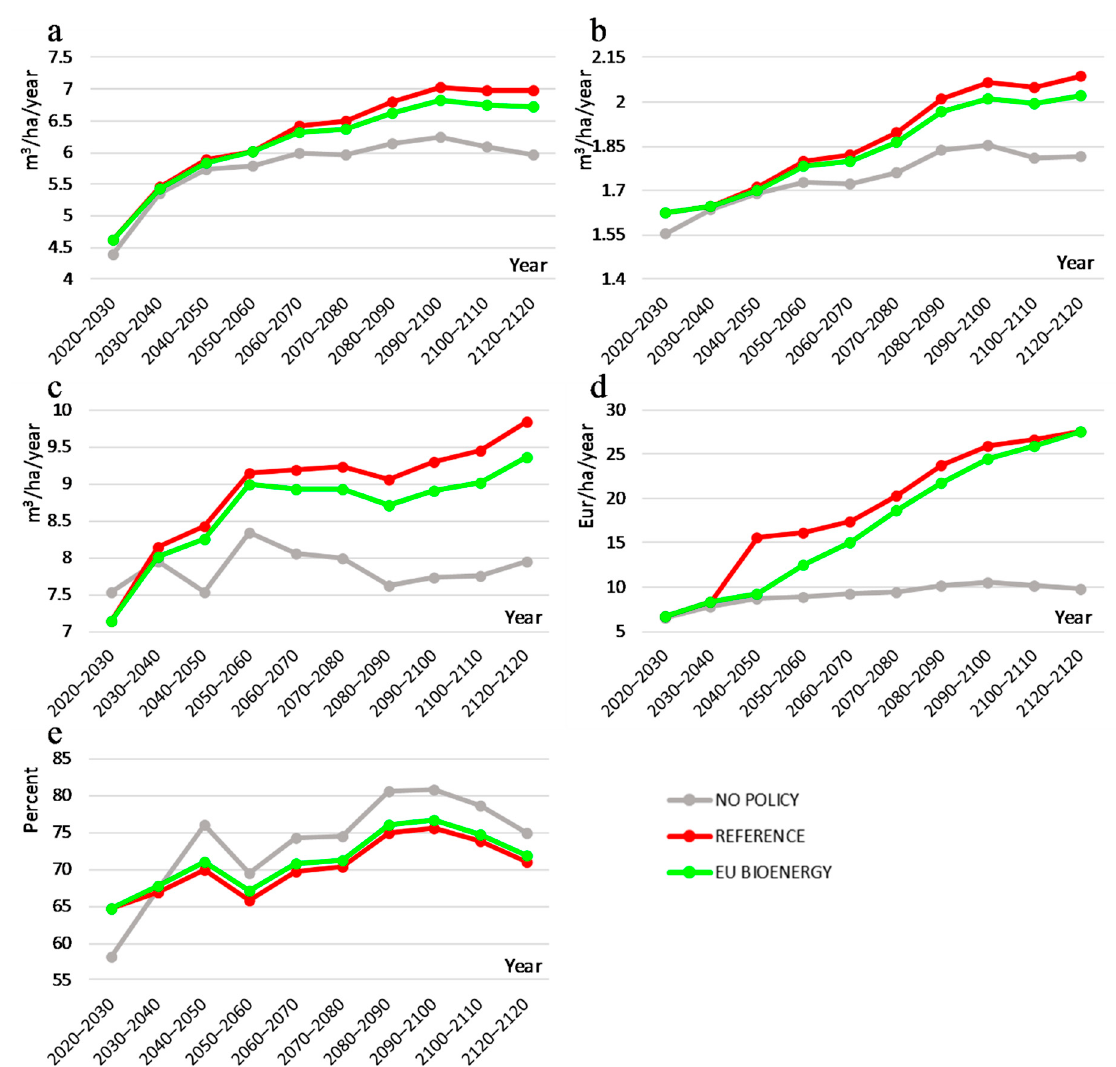
Figure 5. Selected attributes of Lithuanian forests during certain simulation steps, depending on future scenarios: ( a ) Volume of annually harvested timber, ( b ) annual natural mortality, ( c ) annual wood volume increment, ( d ) profit from forestry activities, and ( e ) felling rate.